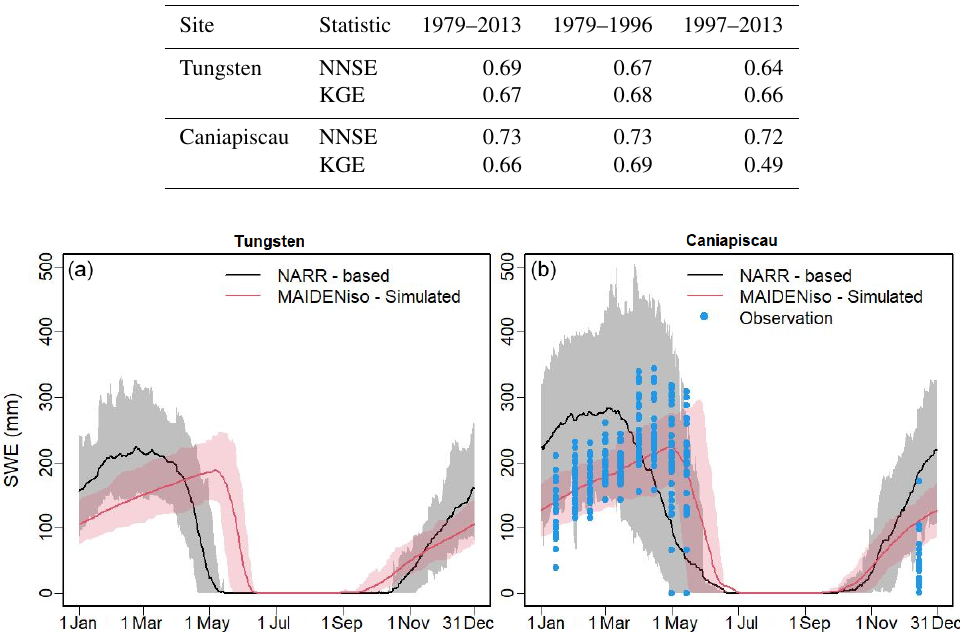
Figure 3. Snow water equivalent (SWE) averaged over 1979–1997 at the (a) Tungsten and (b) Caniapiscau sites, extracted from the NARR data (black) and simulated by MAIDENiso (red) using NARR meteorology. The solid line indicates the average of the same day of the year (DOY) during this period, and the shadows indicate the 2 σ variability. Direct observations of SWE at Caniapiscau, taken at discrete intervals, are shown as blue dots.